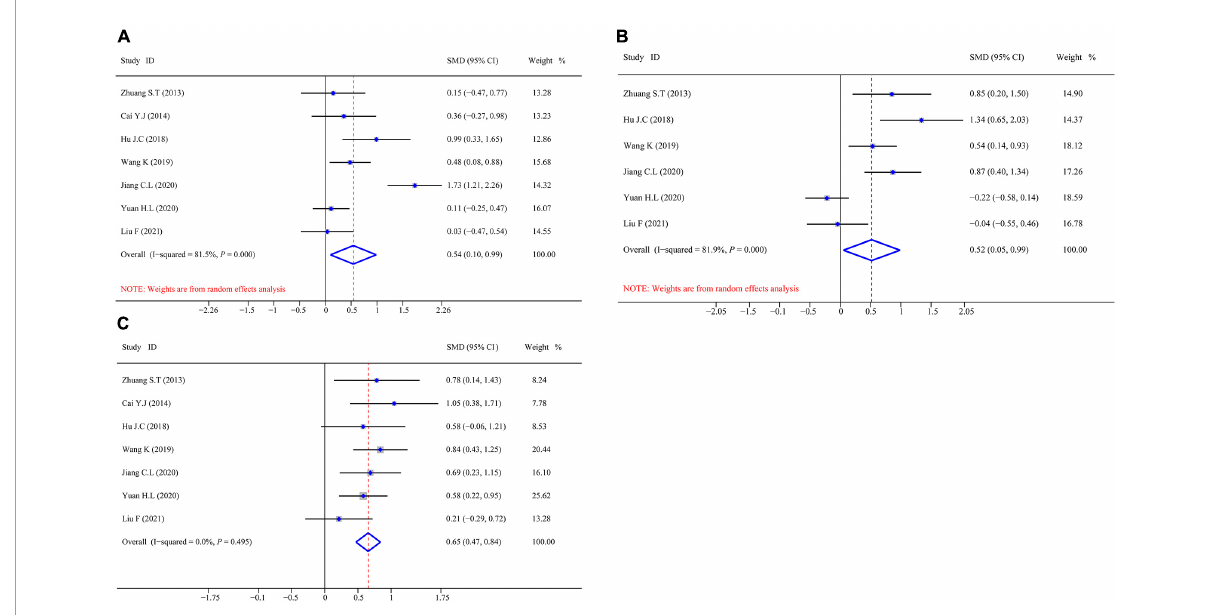
FIGURE4 Forest plot and SMD presentation for IgA, IgM, and IgG. (A) Forest plot of IgA; (B) forest plot of IgM; and (C) forest plot of IgG. In all aggregated analyses, IgA and IgM used random-effects model, and IgG used fixed-effect model.